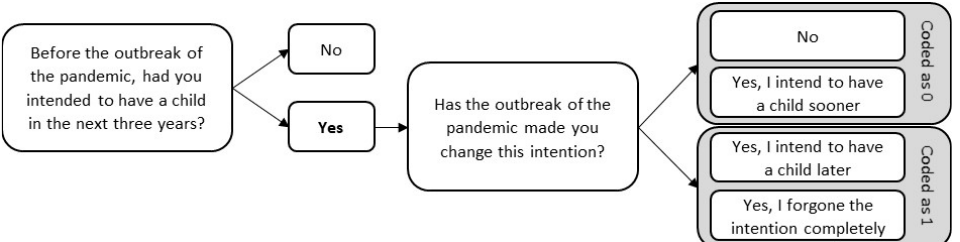
Figure 1 : Construction of the dependent variable: The declared change in fertility intention due to the COVID-19